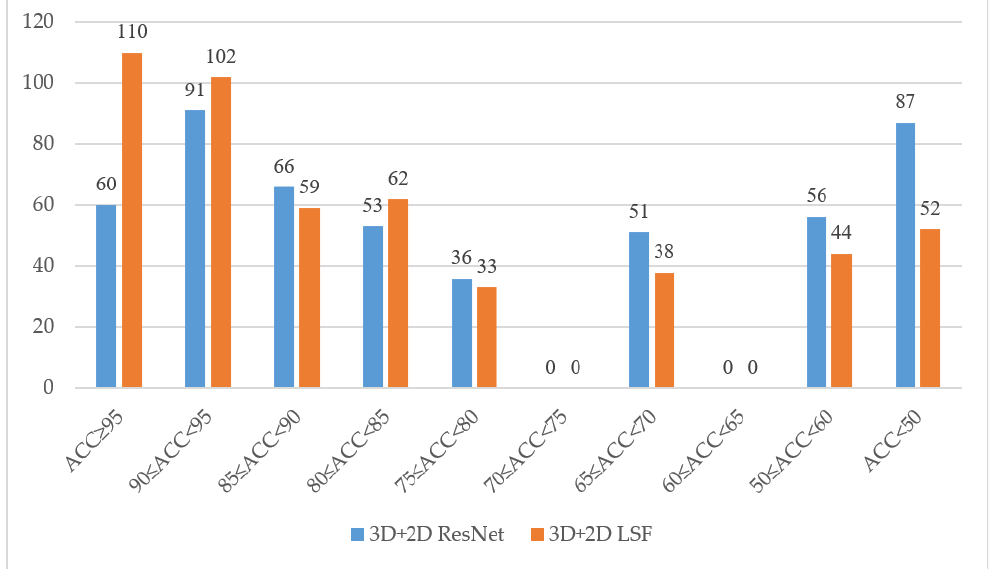
Figure 7. Statistics of accuracy for each class in LRW. The blue histogram is the baseline model we compared, while the orange histogram is LSF.